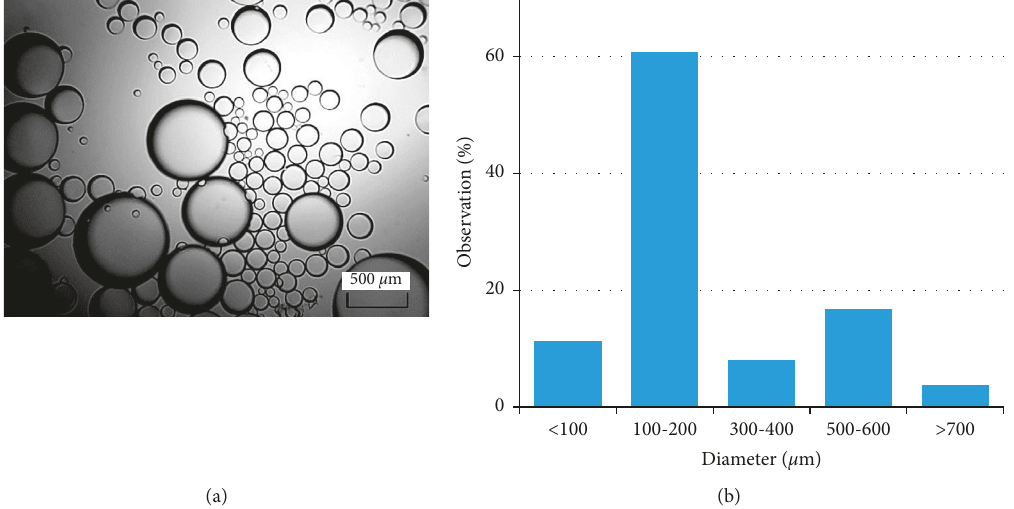
Figure 4: Optical micrographs of CH 2 Cl 2 /ChN-K (1 wt.%) emulsion (a) and oil droplet size distribution histogram